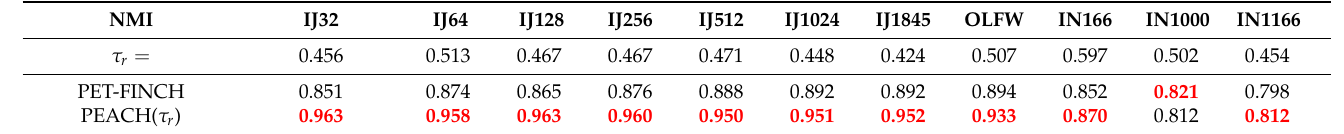
Table 11. PET-FINCH. In this table, we show the NMI scores of FINCH partition which were selected by using our τ r . We estimate the number of clusters of AHC by using τ r and then we choose the FINCH partition, which is closest to the estimated number of clusters. We compare the results with PEACH. We mark the best results